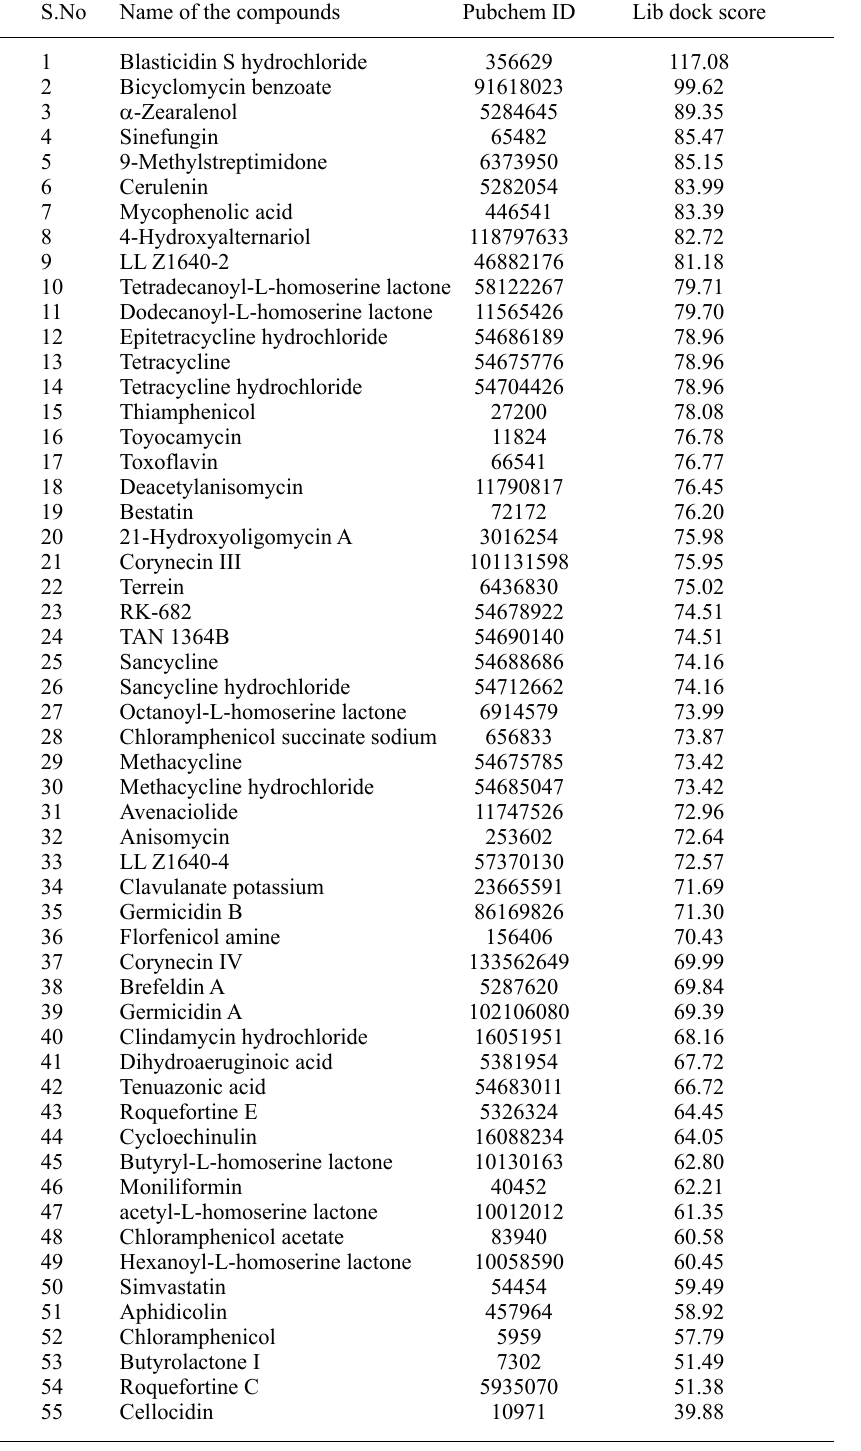
Table 1. List of 55 successfully docked microbial derivatives at the active site of LGMN